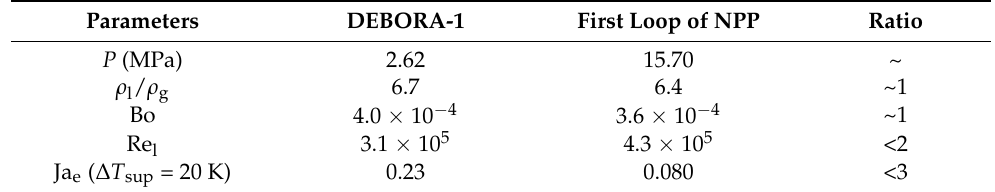
Table 7. Comparison of related nondimensional numbers with DEBORA facility and first loop of NPP.